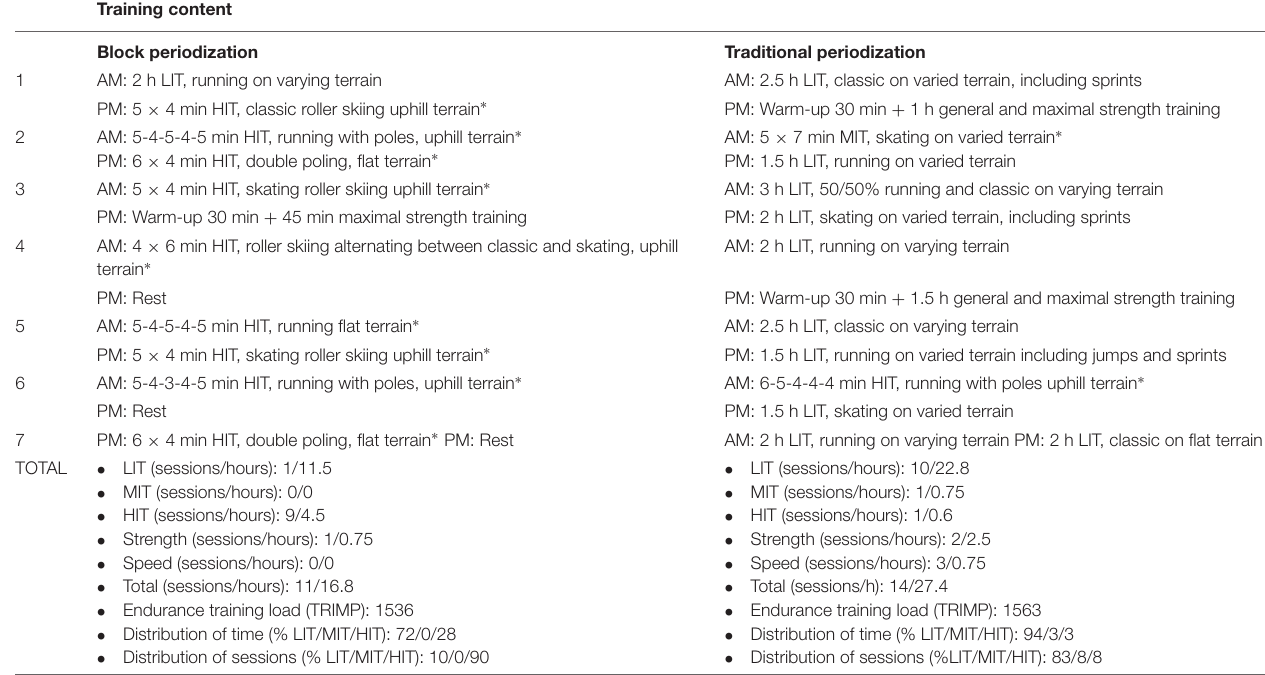
TABLE 2 | Detailed description of the training performed during 7 days of one representative HIT block in BP and one high-load week in TRAD. Training